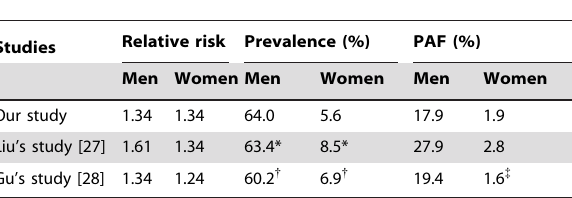
Table 3. Comparison of relative risk, prevalence and population attributable fraction (PAF) for smoking and esophageal cancer in three studies from